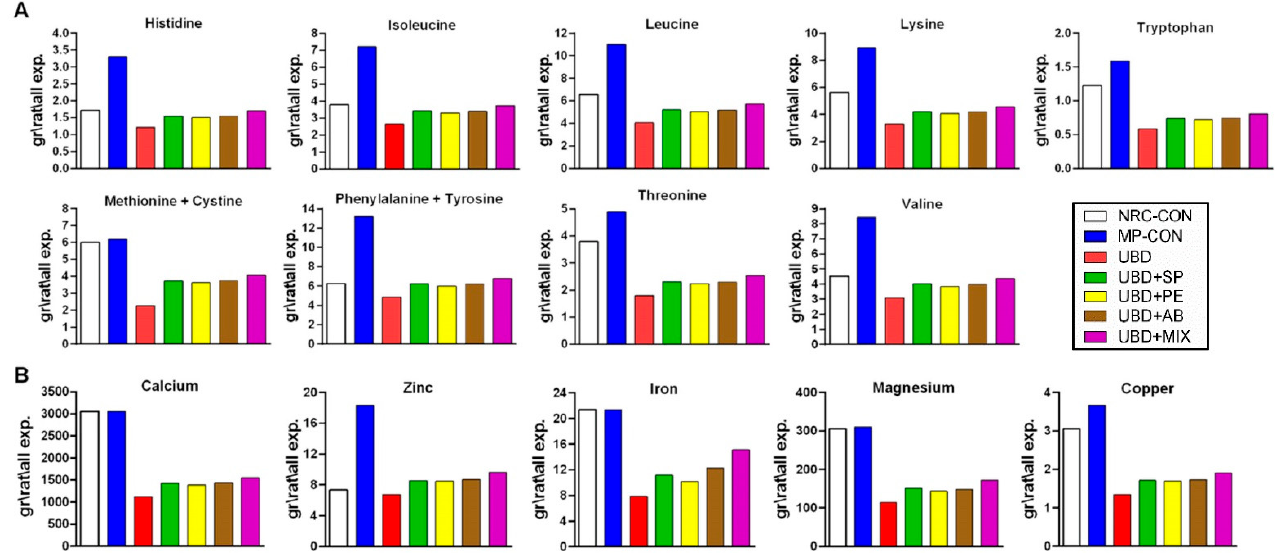
Figure 5. Essential amino acids and minerals consumption. ( A ) Grams of essential amino acids consumed by the rats during the entire experiment. ( B ) Grams of essential minerals for skeletal development consumed by the rats during the entire experiment. The NRC-CON group is based on the CON food intake and the NRC requires recommendations.